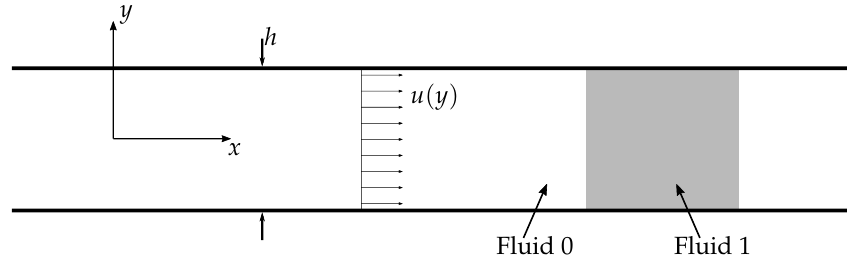
Figure 6. Sharp fluid interface test case.